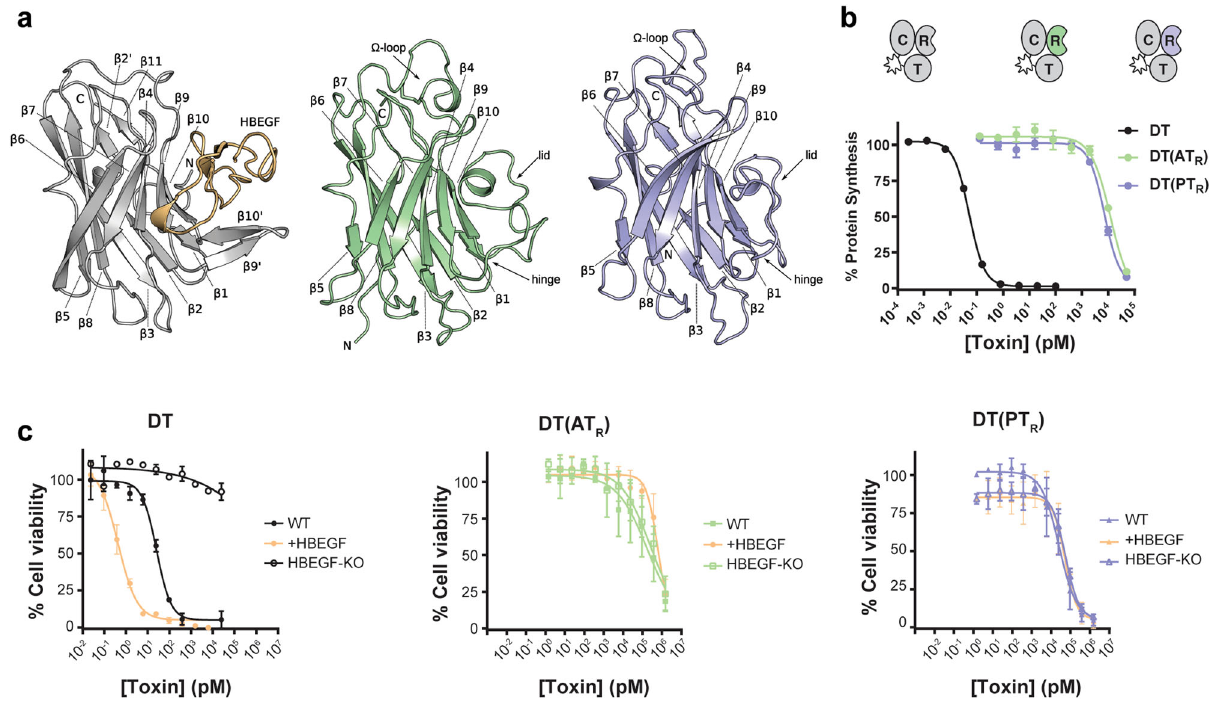
Fig. 3 R-domains of AT and PT do not bind HBEGF. a R-domain structural comparison highlighting conserved β -sandwich motif. The structure of DT R in complex with HBEGF (yellow) was generated from PDB entry 1XDT. The Ω -loop between β 8 and β 9, and the lid structure between β 9 and β 10 are labeled. b Dose titration of DT and DT R-domain chimeras DT(AT R ), and DT(PT R ) on Vero cells (mean ± SD, n = 3); n = 3 biological replicates. c Dose titration of DT, DT(AT R ), and DT(PT R ) on WT, HBEGF KO and + HBEGF cells (mean ± SD, n = 2); n = 3 biological replicates. DT sensitivity (EC 50 ) tracked with expression of HBEGF (WT — 26 pM, HBEGF KO -N/A, + HBEGF — 0.43 pM). Sensitivity to DT(AT R ) and DT(PT R ) was unaffected by HBEGF expression (WT — 169 and 25 nM, HBEGF — 245 and 55 nM, + HBEGF — 608 and 50 KO